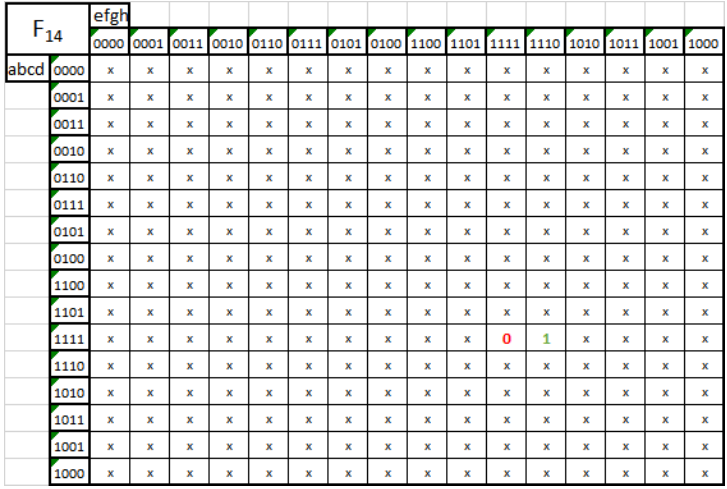
Figure 8. Karnaugh map for the 14th output of the Huffman encoder for Green and Blue